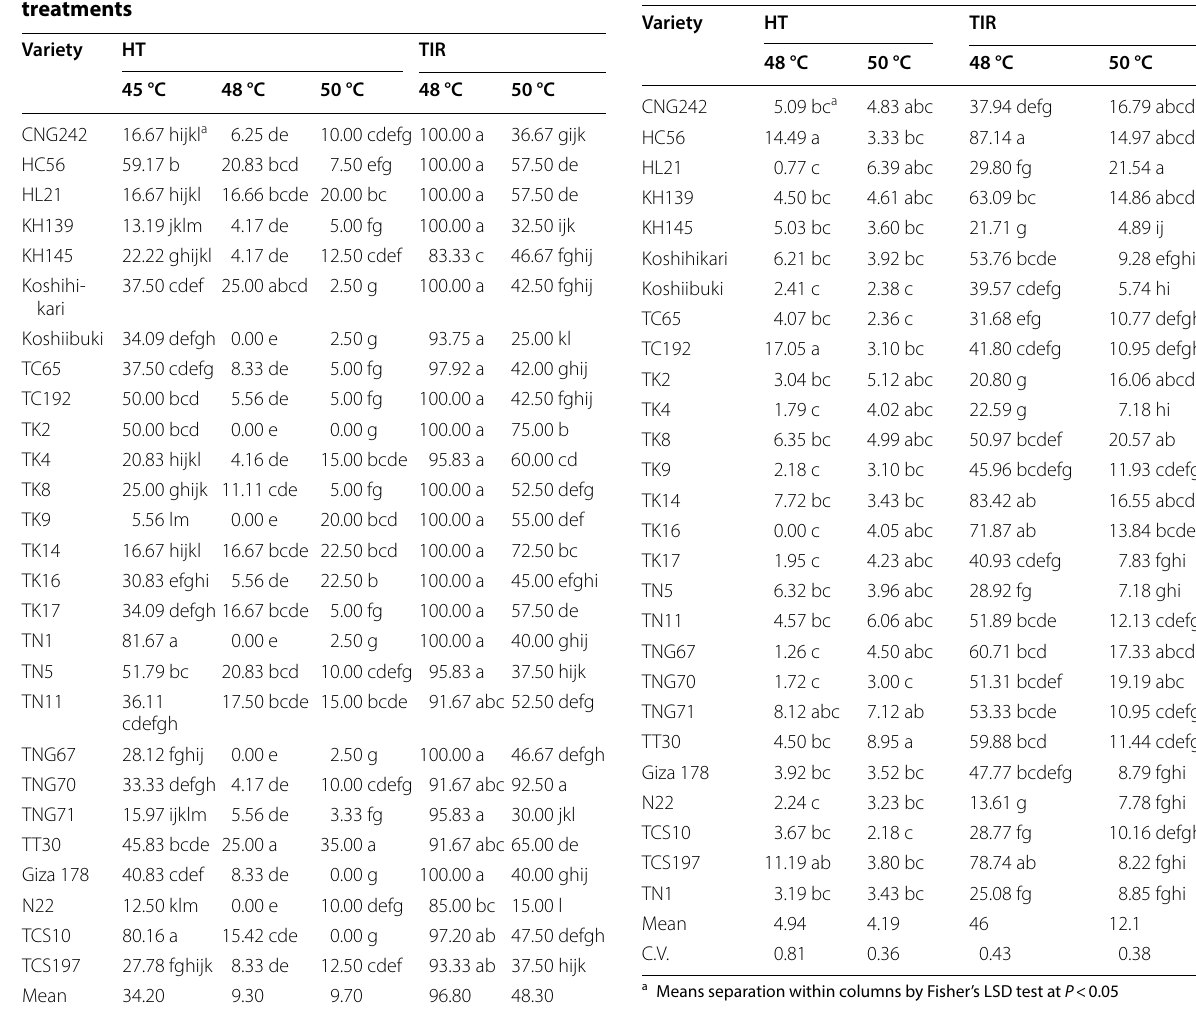
Table 4 Influence of HT and TIR treatments on the shoot RGR (%) of the rice